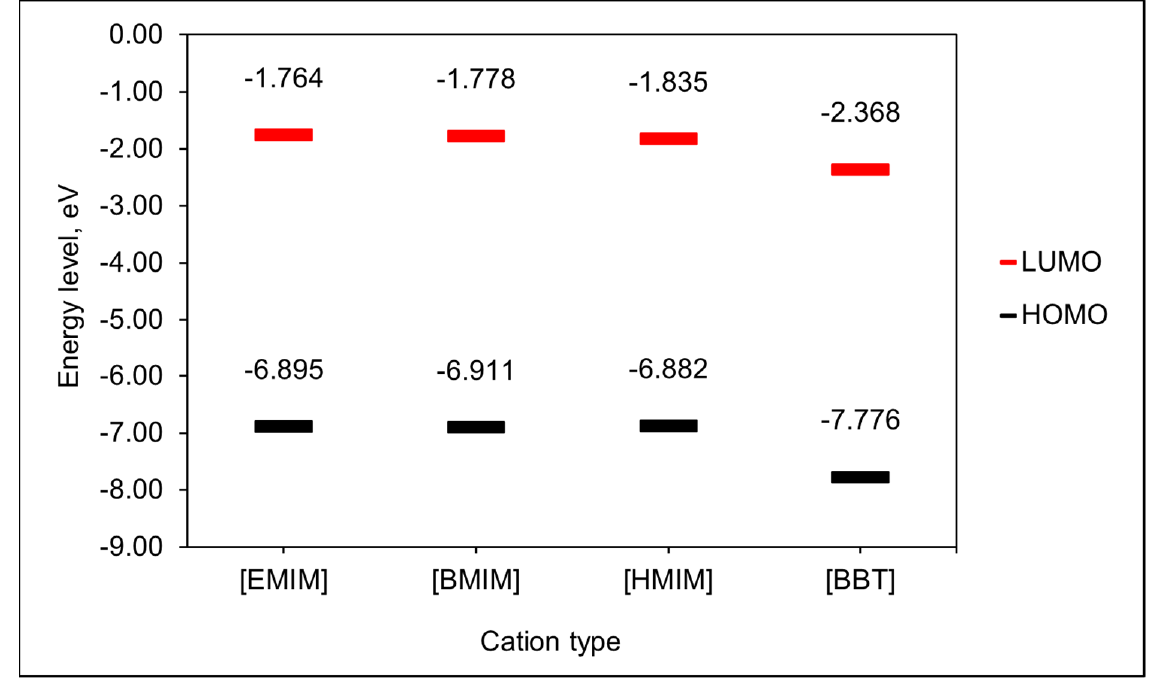
Figure 6. HOMO–LUMO energy levels for different cations.